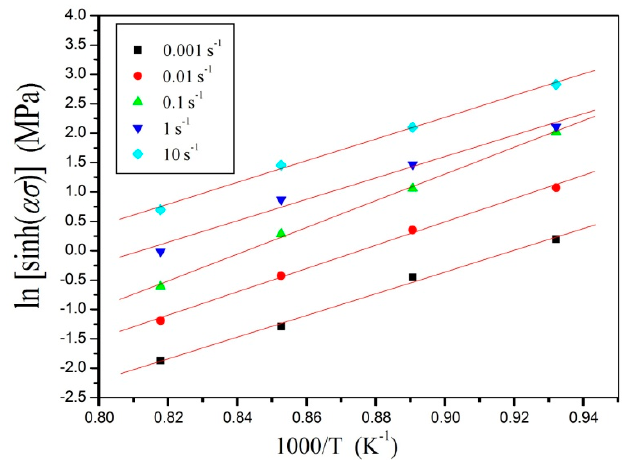
Figure 7. Evaluating the value of activation energy by plotting ln[sinh( ασ )] versus 1000/ T .